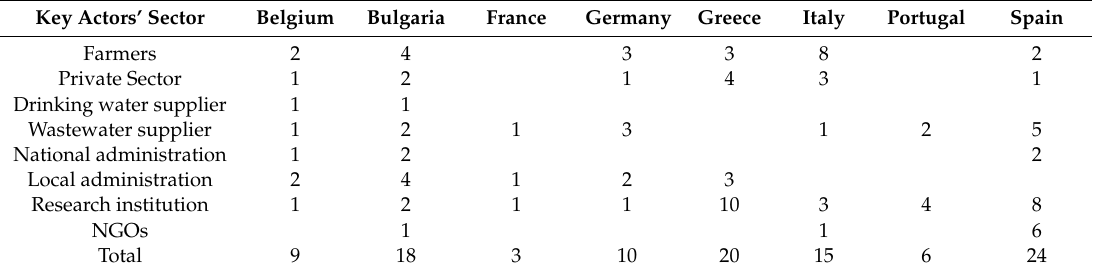
Table A4. Resume of key actors participating in the SWOT analysis, original